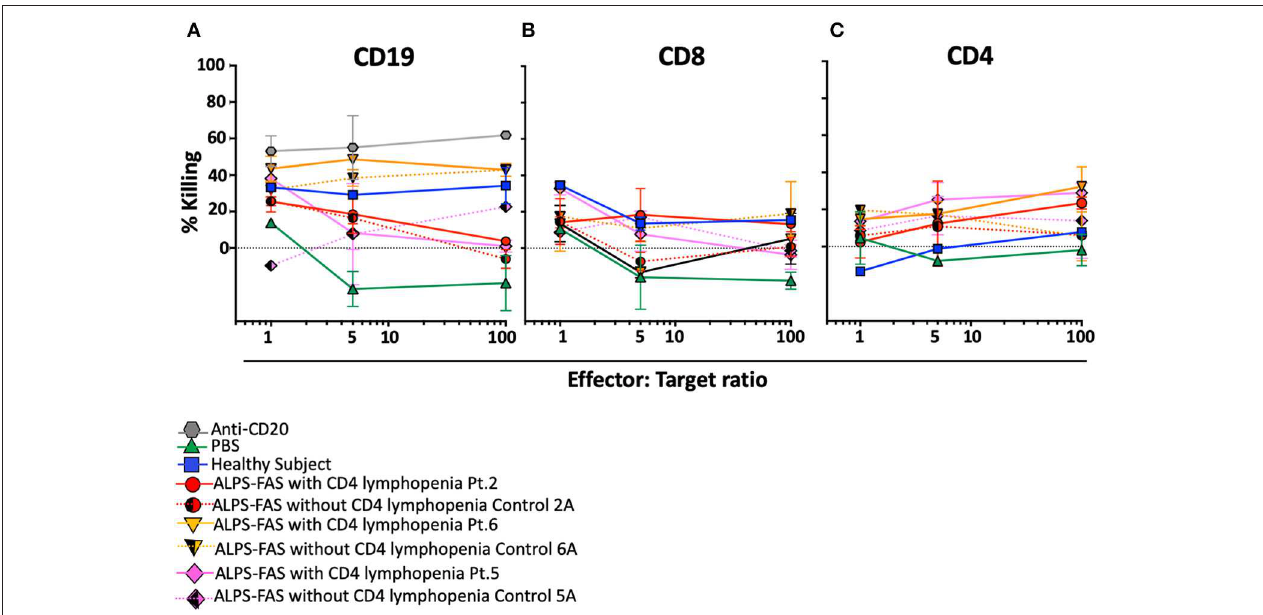
FIGURE 6 | NK-mediated antibody dependent direct cytotoxicity of CD19, CD4, or CD8T cells in the patients with ALPS with or without CD4 lymphopenia. Killing is expressed as percentage of untreated control. CSFE stained after incubation at 4 different E:T ratio (1, 5, 50, 100) with autologous NK cells in presence of monoclonal antibody Anti-CD20 (positive control for NK mediated ADCC, gray hexagon), PBS (green triangle), and plasma from healthy control (blue square), ALPS-FAS patients with CD4 lymphopenia (red circle, orange triangle, pink diamond, continuous lines) and relative matched controls with ALPS-FAS and no evidence of CD4 lymphopenia (hatched red circle, hatched orange triangle, hatched pink diamond, dotted lines). (A) NK-mediated ADCC killing of CD19 B cells. (B) NK-mediated ADCC killing of CD8T cells. (C) NK-mediated ADCC killing of CD4